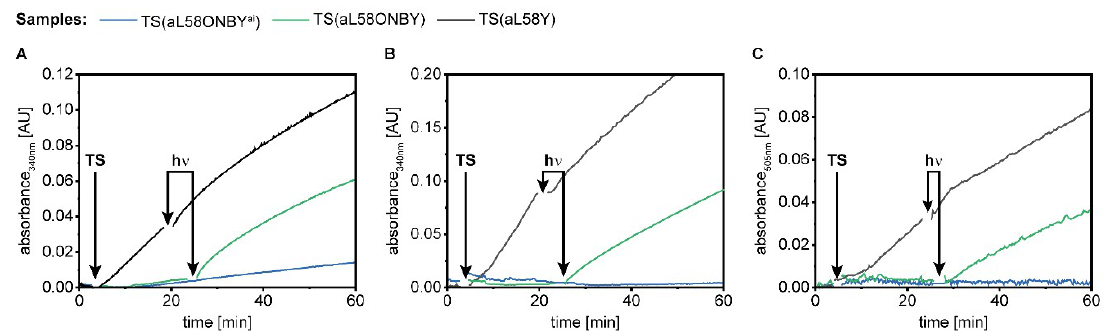
Figure 8. Direct light-activation of TS(aL58ONBY) compared to a TS(aL58ONBY ai ) control (kept in the dark) and a TS(aL58Y) control (irradiated simultaneously). ( A ) TrpA reaction: 50 mM Tris·HCl pH 7.8, 100 mM NaCl, 5 µM GAP dehydrogenase, 100 µM IGP, 5 mM NAD + , 20 mM Na 2 HasO 4 , 40 µM PLP, and 1 µM TS (5:1 TrpA:TrpB). ( B ) TrpA reaction in presence of serine: 50 mM Tris·HCl pH